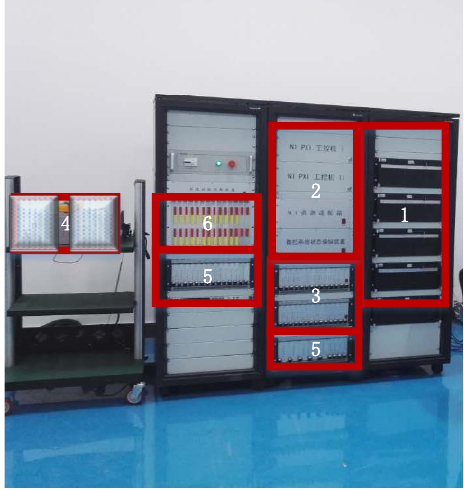
Figure 23. HIL platform.